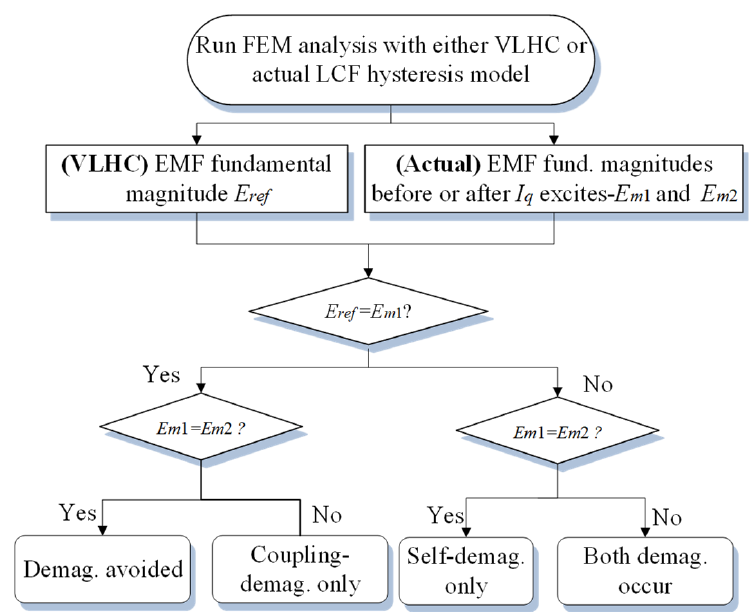
Figure 10. Flowchart of the procedure of the UD type identification.